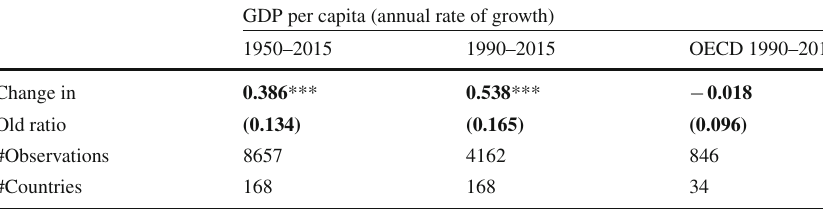
Table 1 Population ageing and growth of GDP per capita